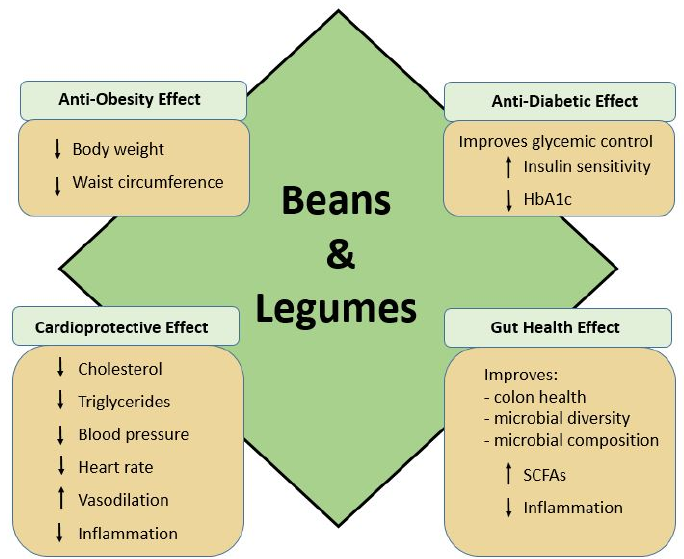
Figure 1. Health benefits of beans and legumes.